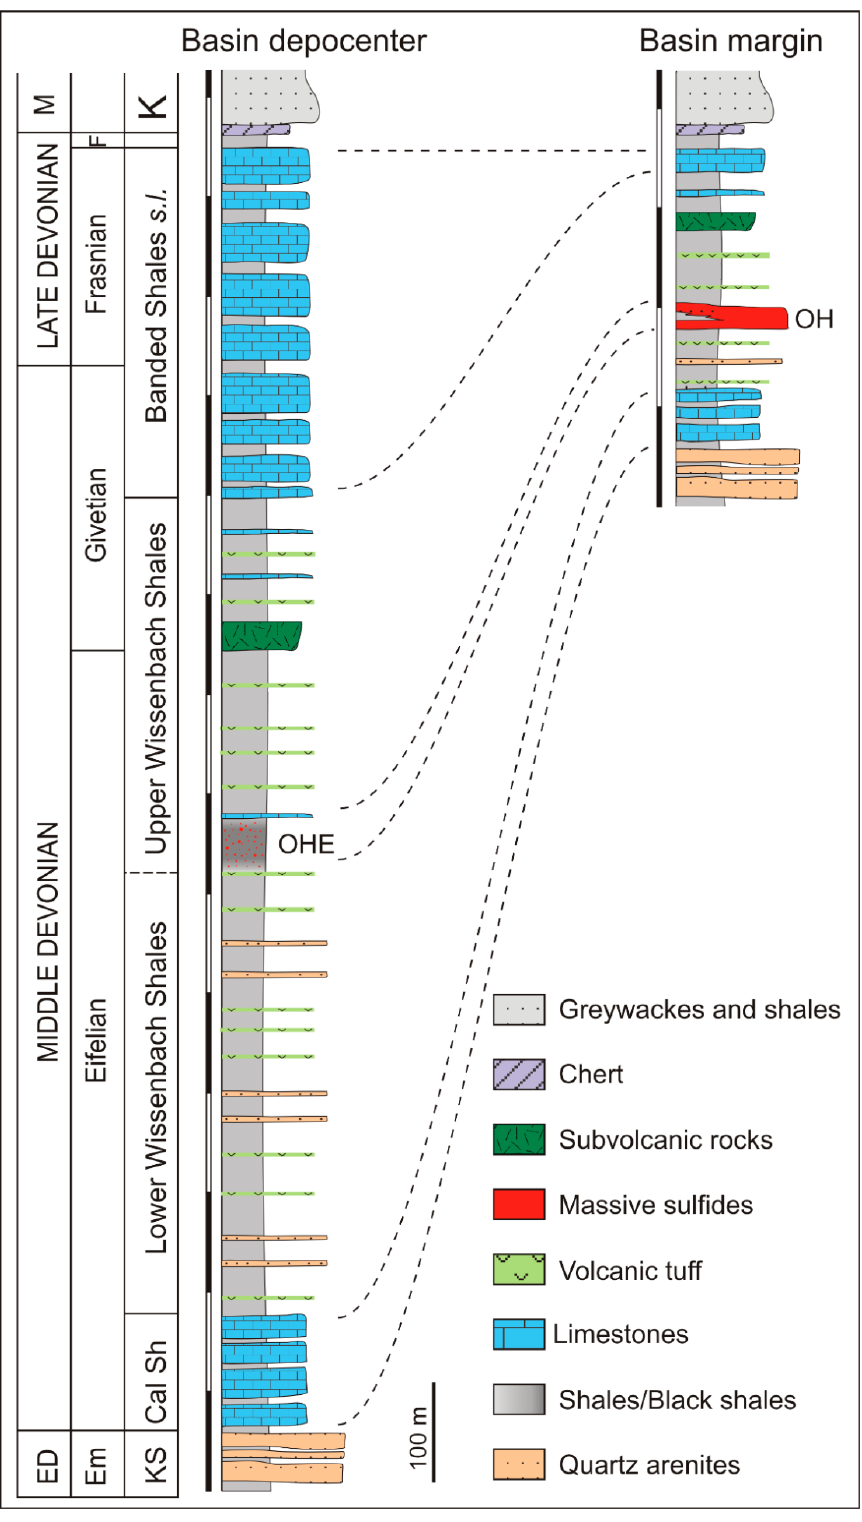
Figure 2. Proposed paleogeographic model for the Goslar Basin at the massive sulfide deposition time (middle Eifelian). Red arrows indicate pathways of basinal fluids. OHE; Ore horizon equivalent. Modified from Hannak [41] and Sáez et al. [38].